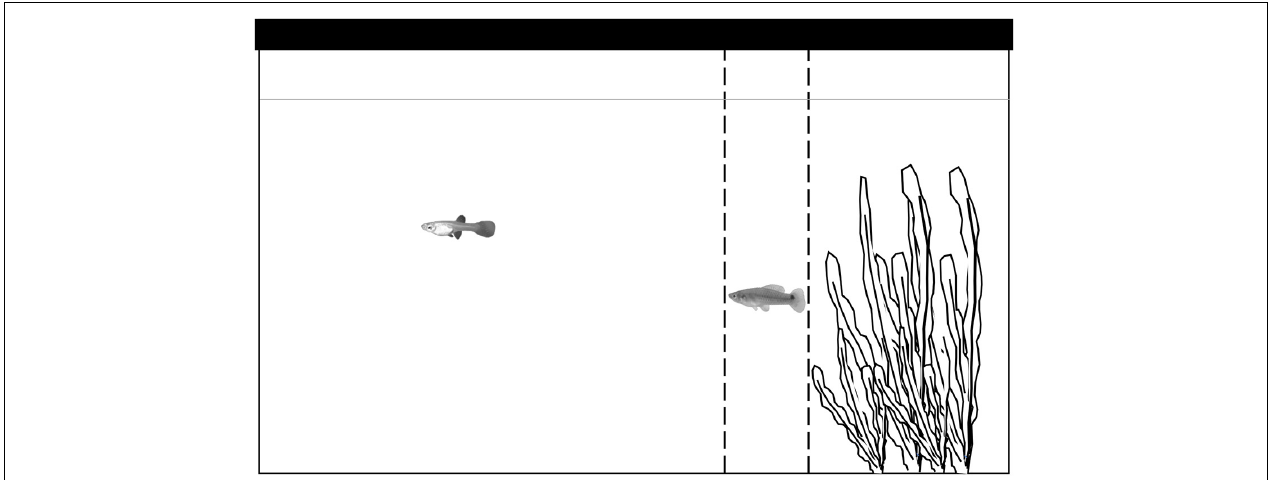
FIGURE 1 | Diagram of the experimental tank set up. Plastic plants were used to simulate a refuge, the refuge was identical for all observations. Observations started when fish were gently released in the upper right corner and lasted until both fish left the refuge, we considered fish had left the refuge when they were one body length (distance between dashed lines) away from the end of the refuge (dashed line closest to plants). We averaged the standard length of 10 fish randomly selected from the stock to calculate the distance between dashed lines, these lines were indicated for the observer and invisible to the fish.